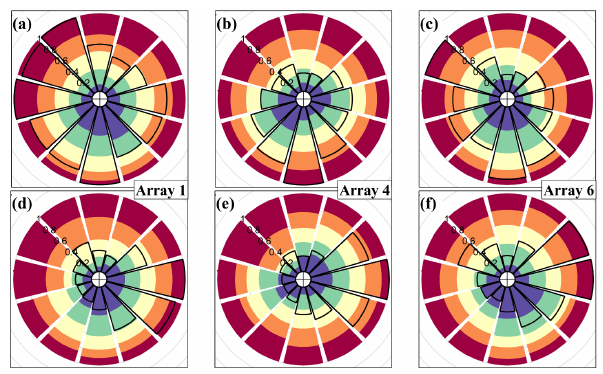
Figure 8. Residence-time (see Sect. 2.3) quintiles by wind direc- tion for the (a–c) leaf-on and (d–f) leaf-off periods (Sect. 2.2 for observation details). (a, d) Array 1; (b, e) array 4; (c, f) array 6 (Fig. 1 and Sect. 2.1). The colours indicate the proportion of τ val- ues within each quintile, increasing from blue (lowest 20% of τ val- ues across the whole site) to red (highest 20% of τ values across the whole site). For example, panel (a) shows that for southerly winds, a higher proportion of τ values are in the first and second quintiles (more blue and green in the southerly wind sectors) and a lower proportion are in the fifth quintiles (less red in the southerly wind sectors). In other words, for array 1, lower τ values are more com- mon for southerly winds. The solid black line shows the relative frequency of each wind sector across the whole leaf-on and leaf- off measurement periods, with the scale 0–1 indicated by the radial